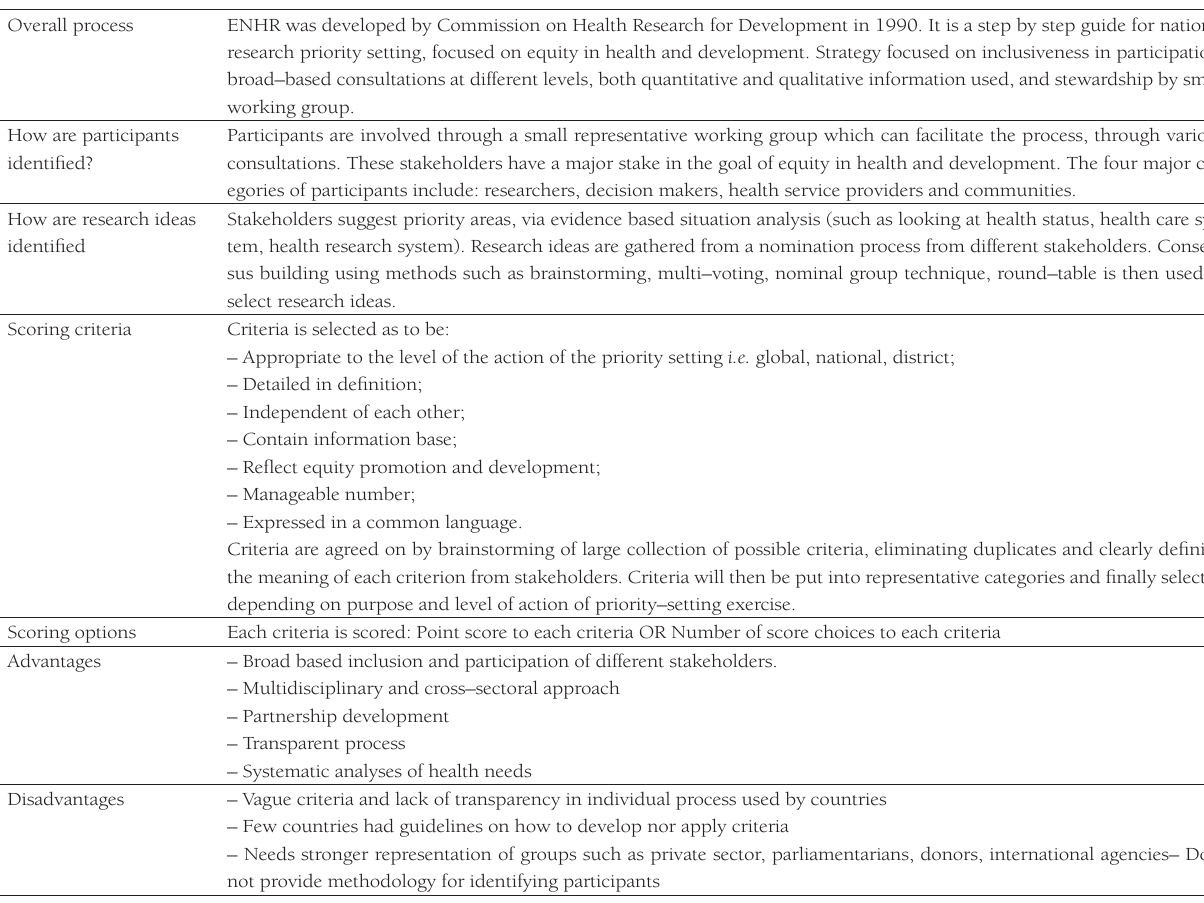
Table 1. Brief explanation of the Essential National Health Research (ENHR) [ 4–6